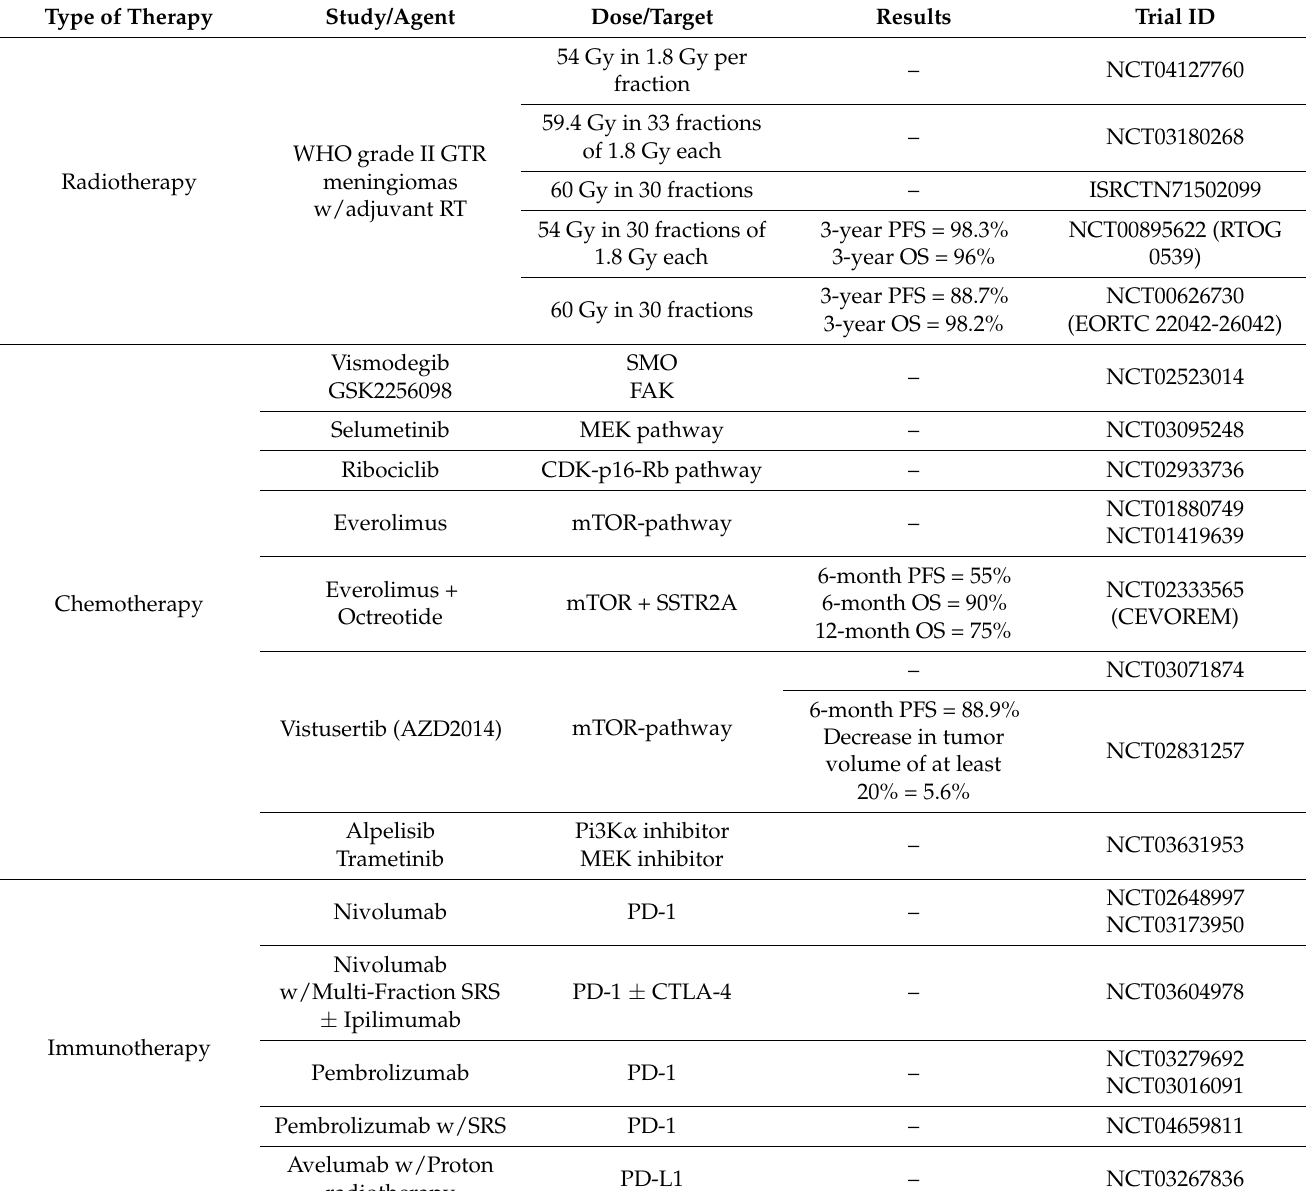
Table 6. Summary of current areas of